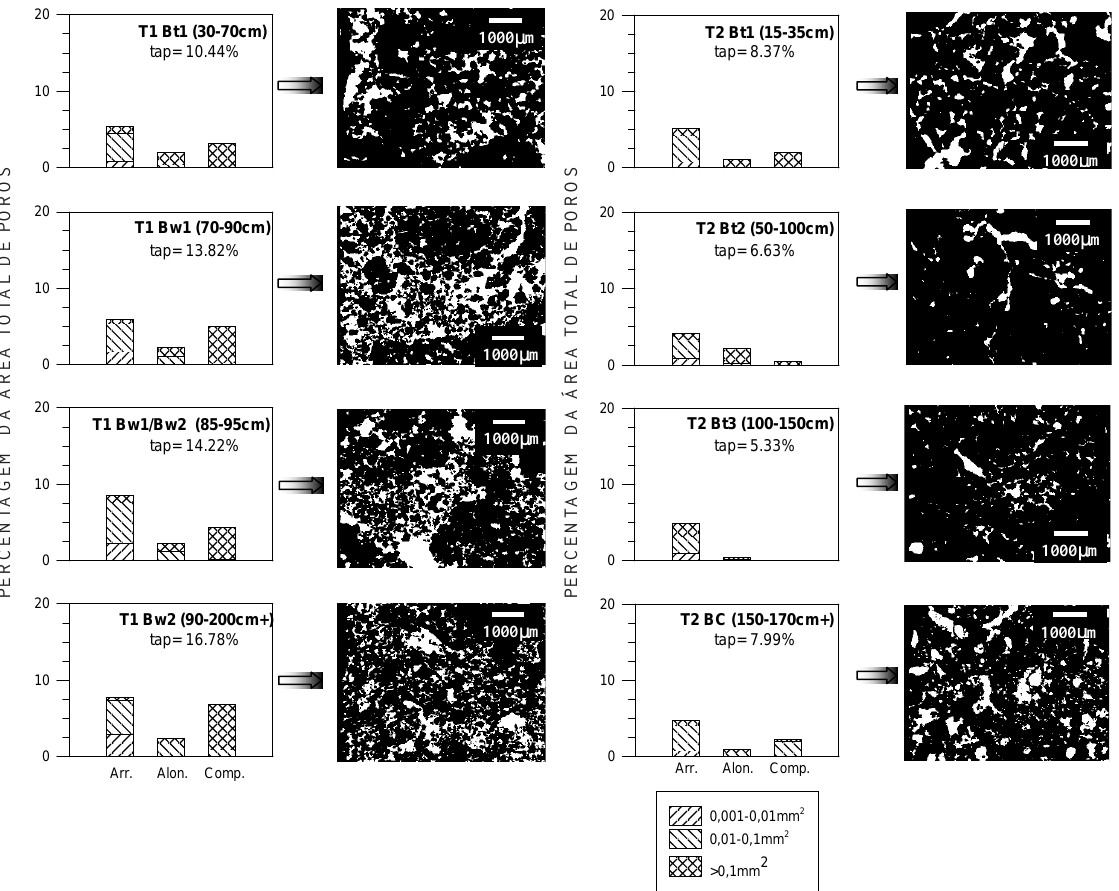
Figura 2. Distribuição da porosidade total (tap), segundo a forma e o tamanho dos poróides de cada horizonte dos perfis 1 (T1) e 2 (T2), e imagens binárias correspondentes (os poróides aparecem em branco e a fase sólida em preto). Arr = arredondados, Alon = alongados, Comp = complexos, Bt = horizonte B nítico, Bw = horizonte B